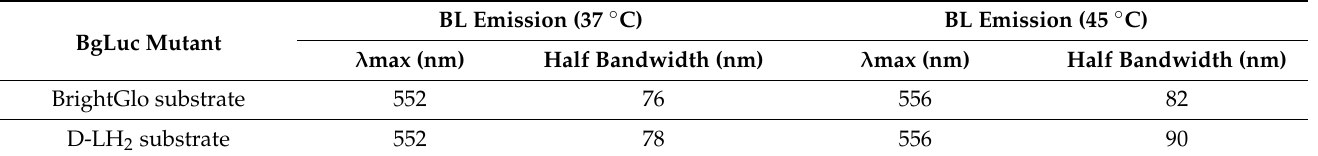
Table 2. λ max and half bandwidth of BgLuc mutant at different temperatures (37 ◦ C and 45 ◦ C).